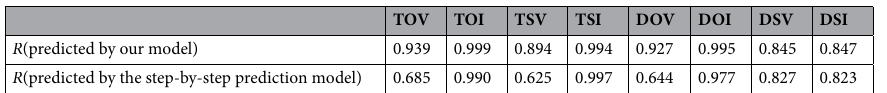
Table 12. Two sets of correlation coefficients of proportion of fixations on AOIs for each experimental condition.